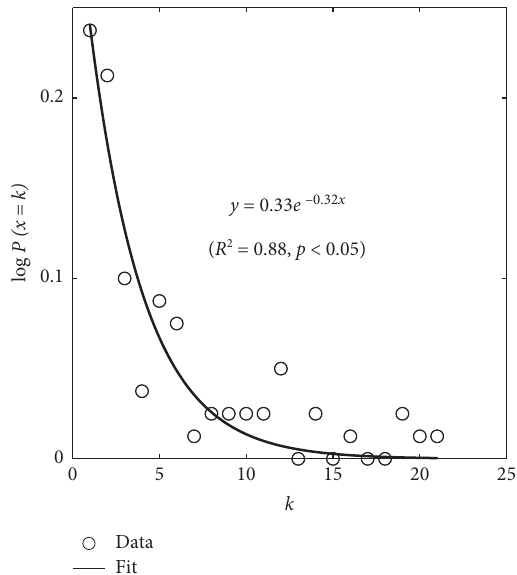
Figure 9: Degree distribution of the road network in Sejong city fitted with an exponential distribution